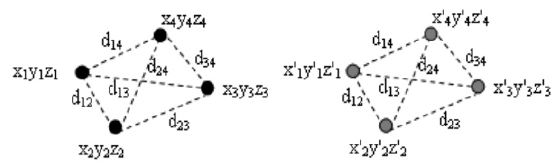
0 y 0 z 0 1 ¯ 1 ¯ 1 , from its ideal marker po-